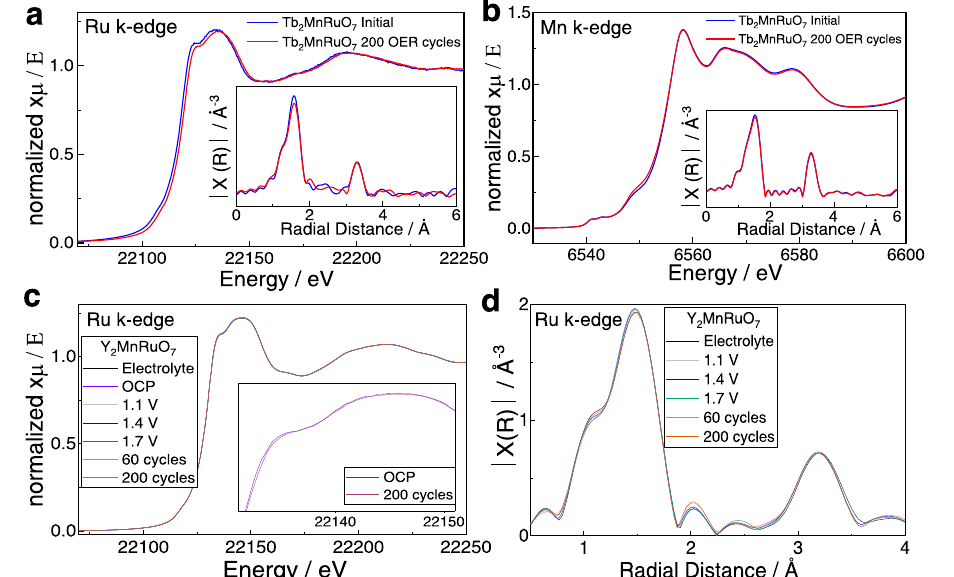
Fig. 5 | XAS measurements on Tb 2 MnRuO 7 and in situ XAS on Y 2 MnRuO 7 . a Tb 2 MnRuO 7 Ru K-edge XANES on fresh catalysts and catalysts after 200 OER cycles. Inset: EXAFS region. b Mn K-edge XANES spectrum for fresh Tb 2 MnRuO 7